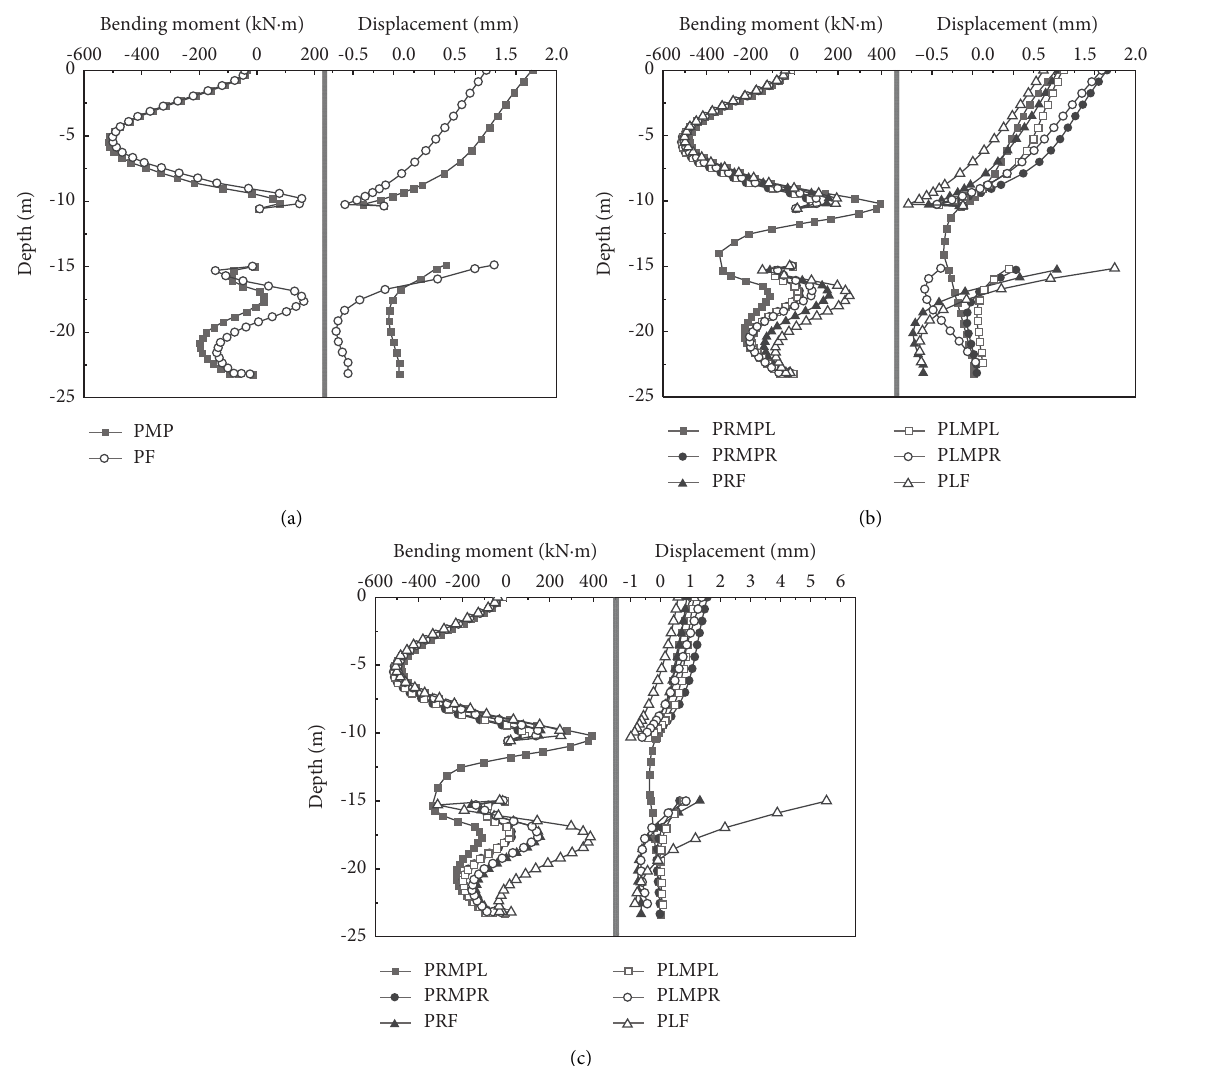
Figure 10: Bending moment and displacement of piles under different construction conditions ( L